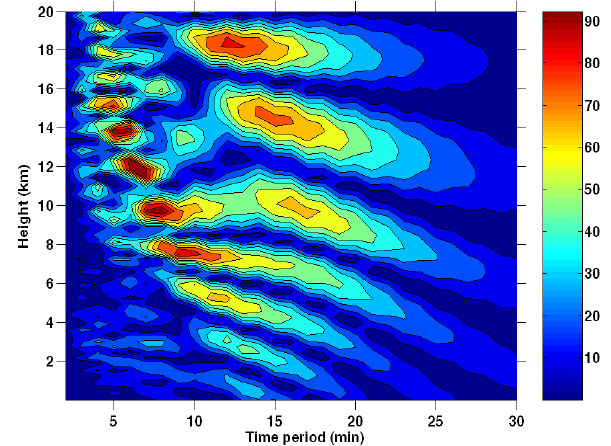
Fig. 3. The CWT amplitude spectra of time series of distance tra- versed by the balloon in each successive